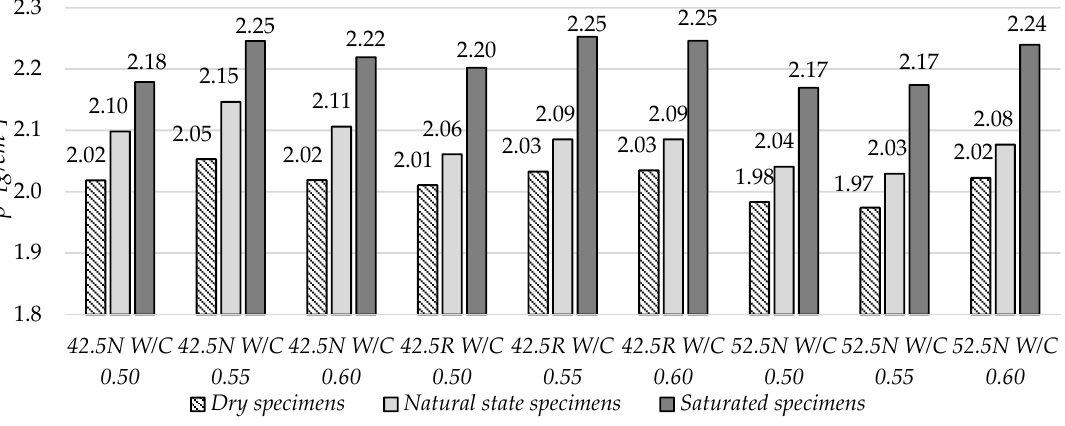
Figure 2. Volume density of dry, saturated and natural state specimens.